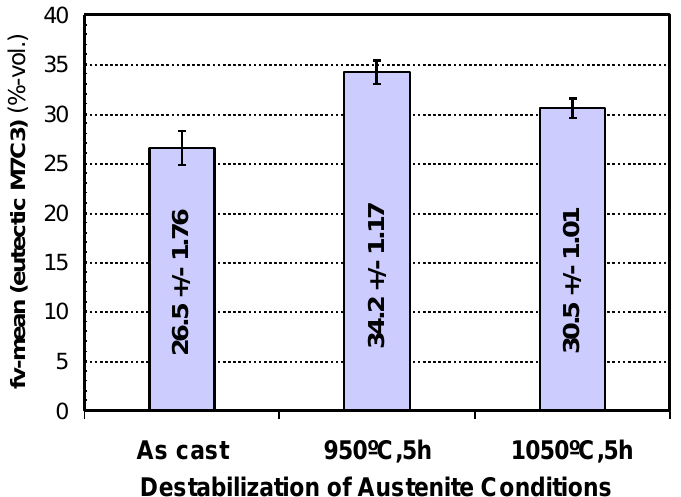
Figure 3. Volume fraction of eutectic carbides after destabilization at the two studied temperatures (%-vol.) and its limit of confidence at 95%.